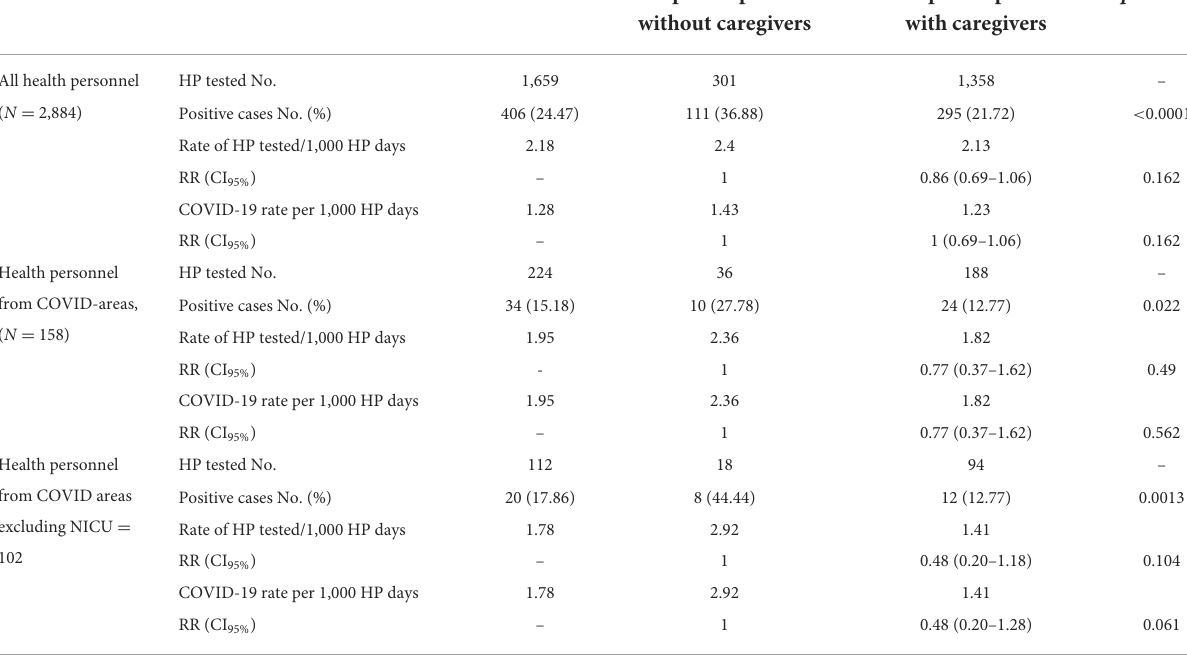
p- Total 1 st period patients 2 nd period patients without caregivers with caregivers